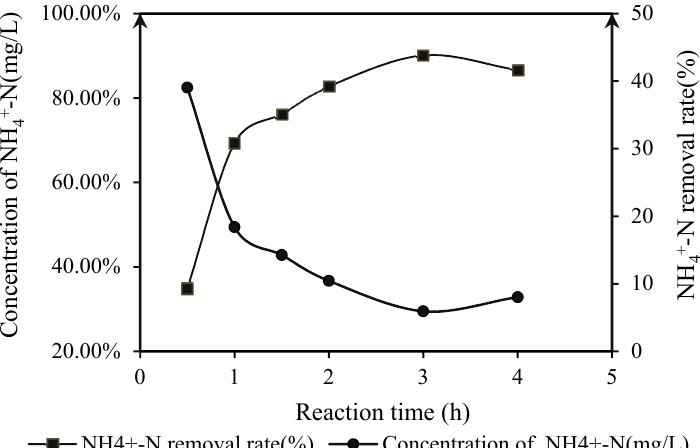
Figure 10. UV irradiation after adsorption.